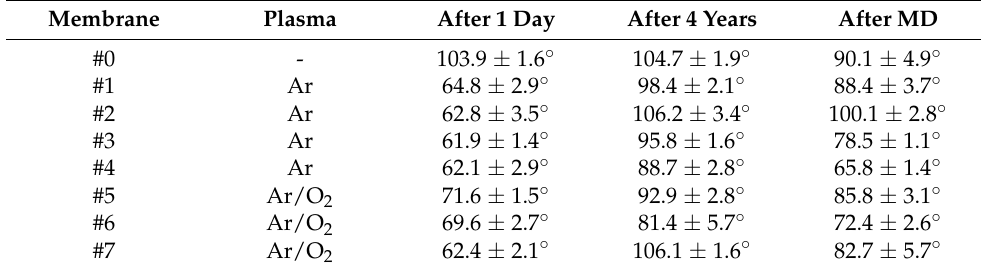
Table 3. Changes of membranes’ water contact angle.